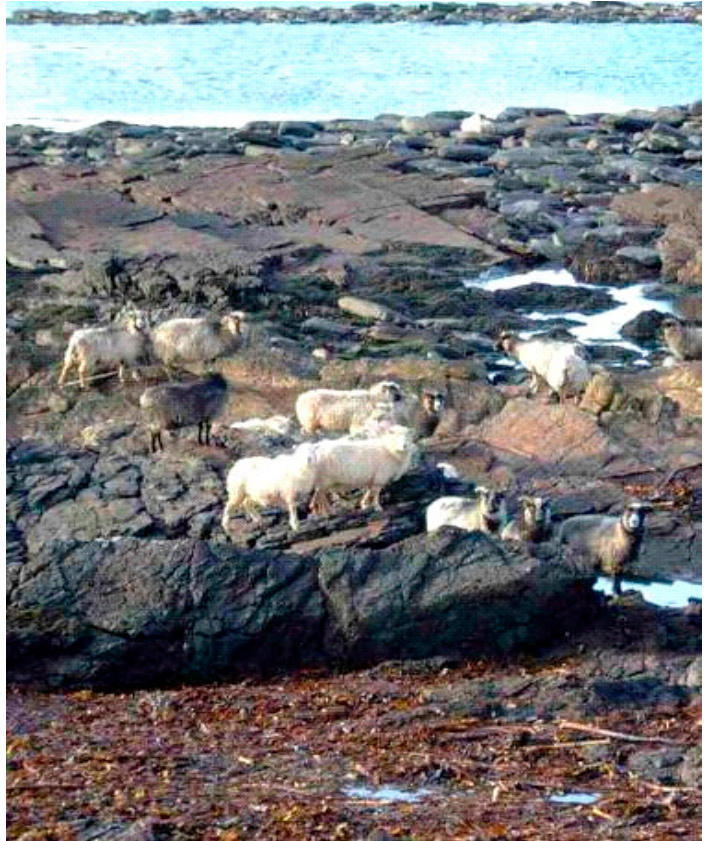
Figure 2. North Ronaldsay (NR) sheep on island foreshore. NR sheep have adapted to survive on seaweed which is very low (<5 ppm) in copper.